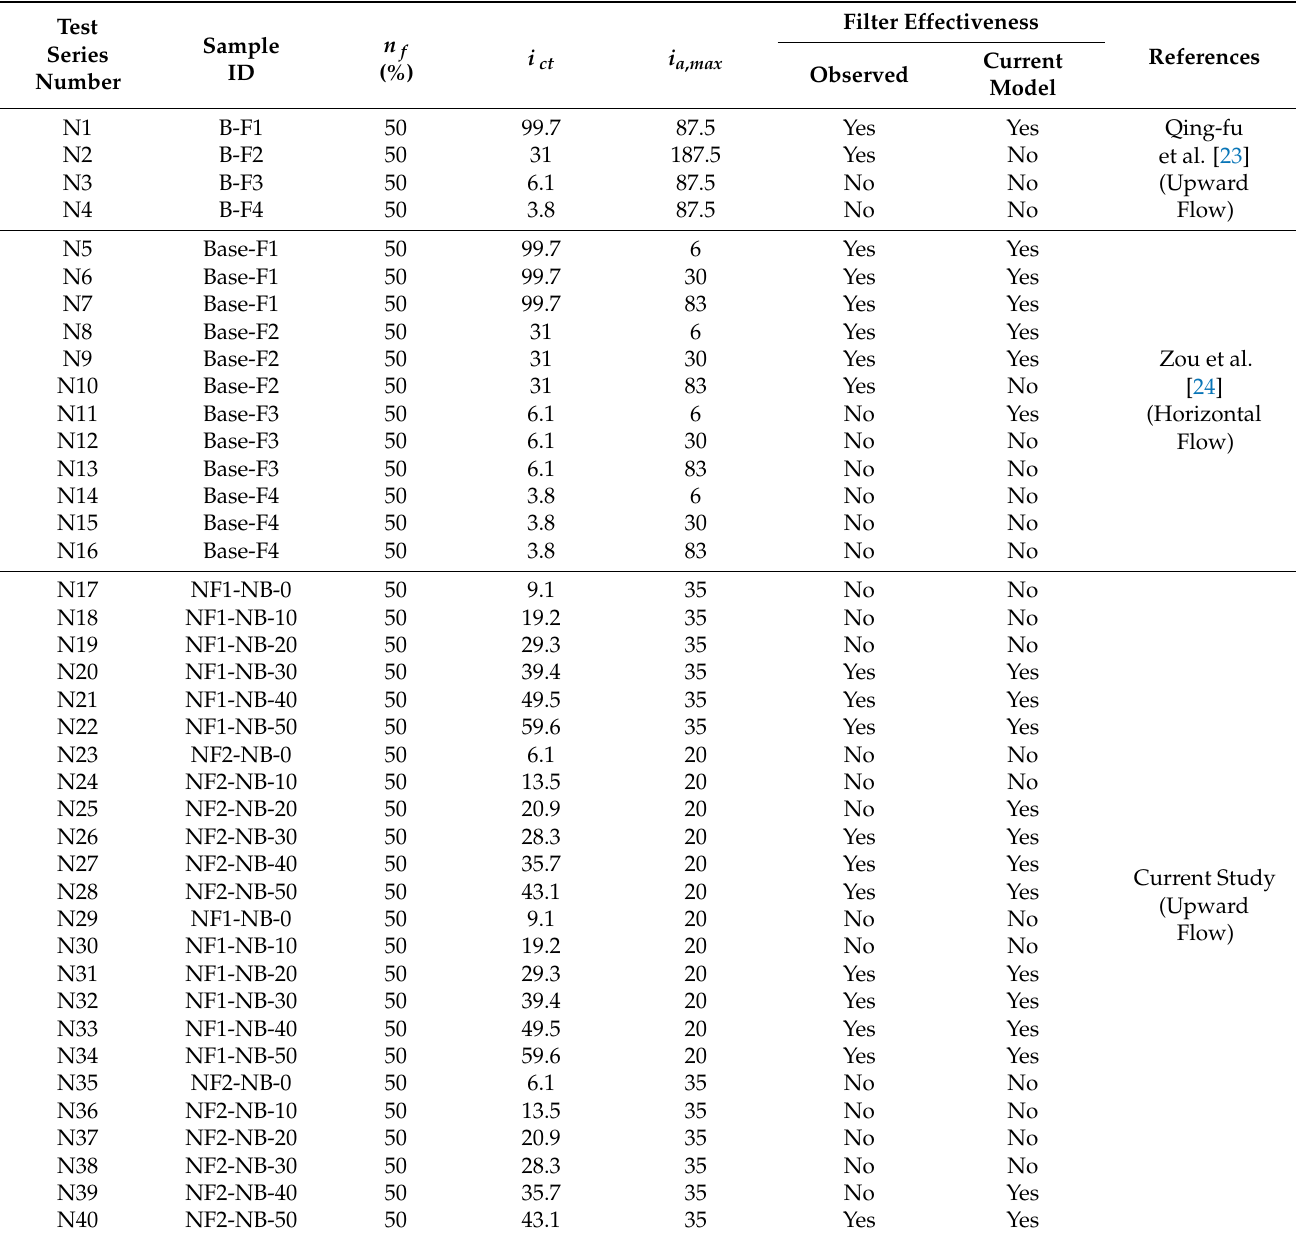
Table 2. Summary of numerical data used for